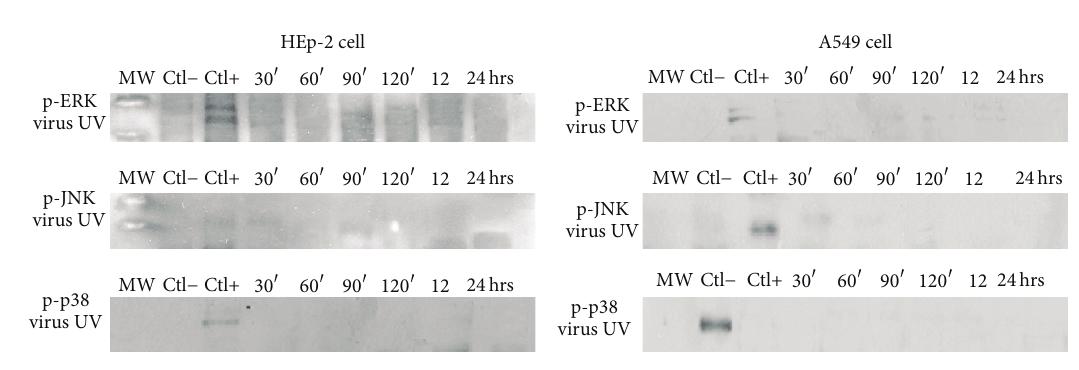
Figure 4: Kinetics of expression of MAPKs in HEp-2 and A549 cells after inoculation with HPIV-1 virus inactive. ERK1/2, JNK, and p38 phosphorylation showed no time points analyzed during 30 min to 24 hrs. Ctl 2nd lane ( − ) refers to the proteins of uninfected cells. The Ctl (+) corresponds to the proteins from cells infected with live virus (90min). Antibodies used are described in Materials and Methods. Western blot assays were performed in